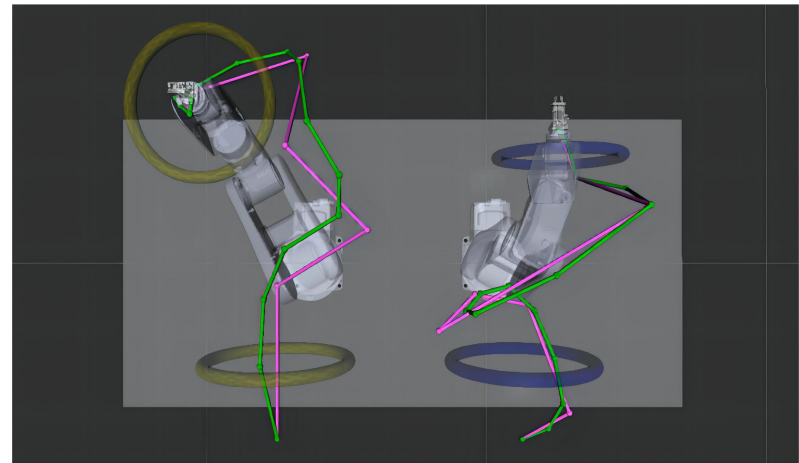
Figure 11. Comparison of simplified path and smoothed path in